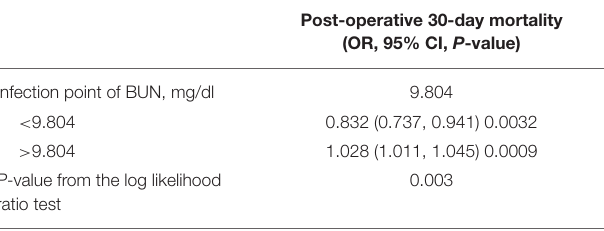
TABLE 3 | The results of the piecewise linear regression. TABLE 4 | Results of interaction analysis and subgroup